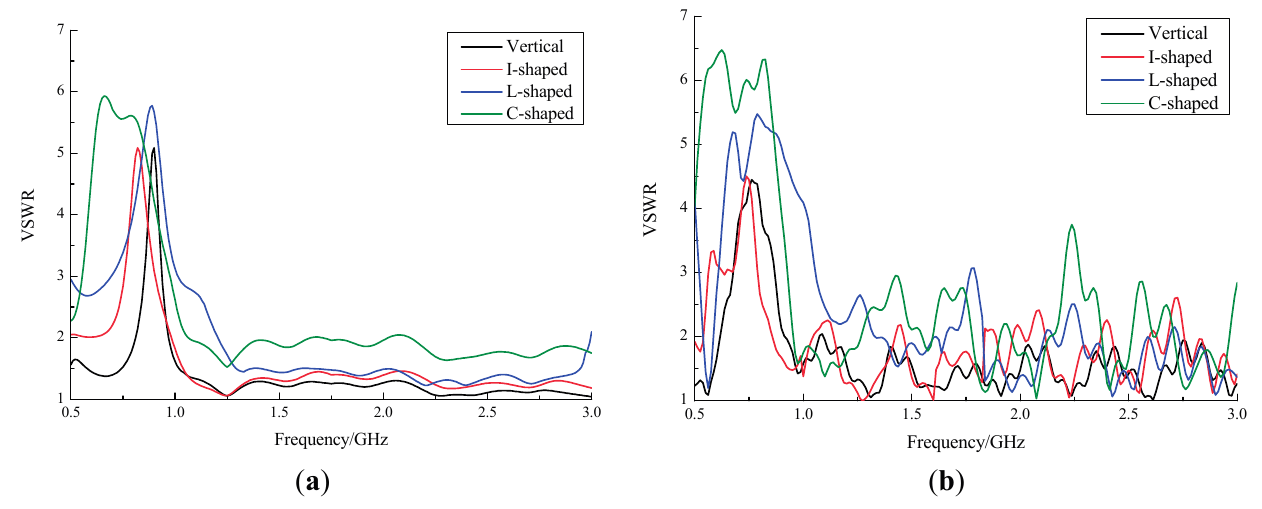
Figure 9. Comparison results of four types of baluns: ( a ) simulation; ( b ) VNA measurement.